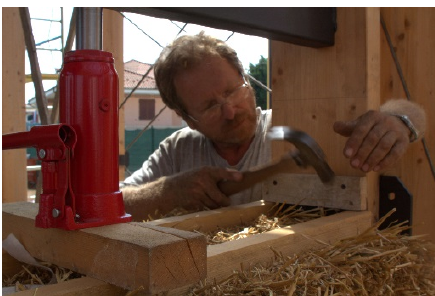
Figure 8. Compression by means of a hydraulic jack and side fixing with screws.